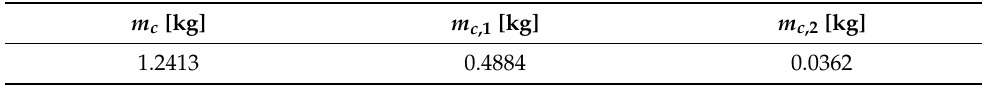
Table 2. Balancing masses for a 3 cylinder in-line